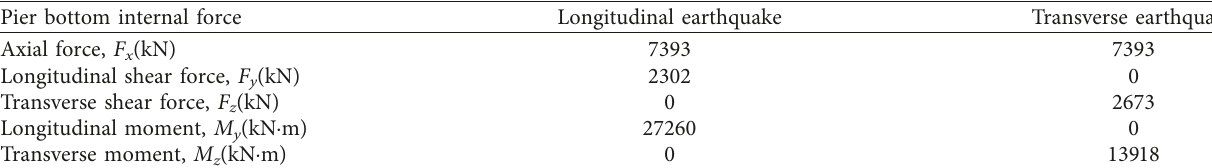
Figure 12: Pier and foundation: (a) cross-section of piers; (b) longitudinal section; (c) overall plan. Table 9: Pier bottom internal forces under low-level earthquake.